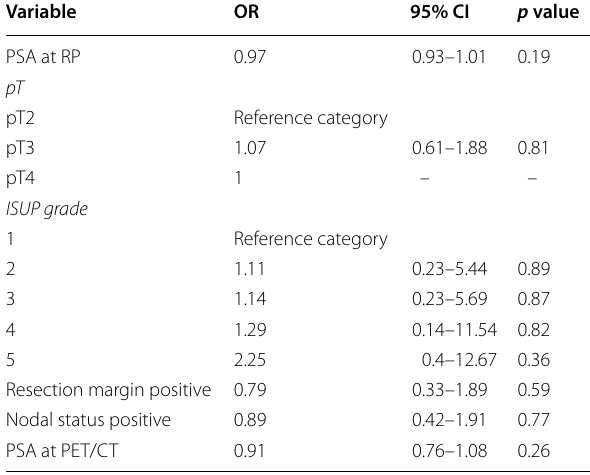
Table 5 Association of clinical variables and change in